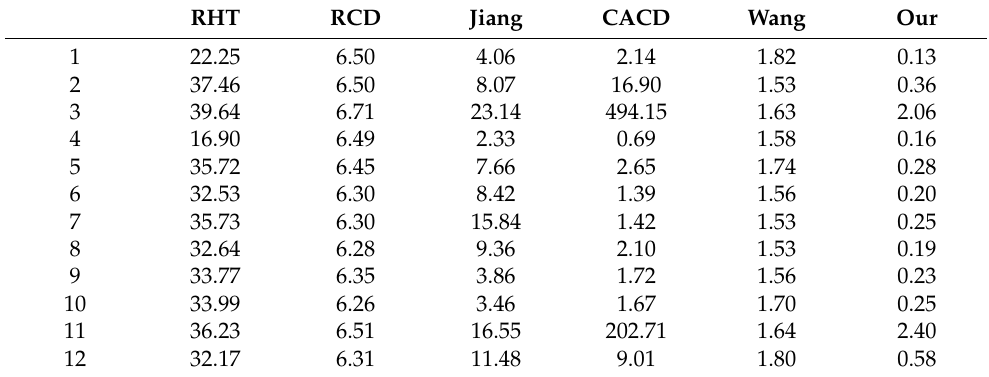
Table 5. Time of RHT, RCD, CACD, Jiang, Wang and our method in the dataset Geometry (unit: s). RHT RCD